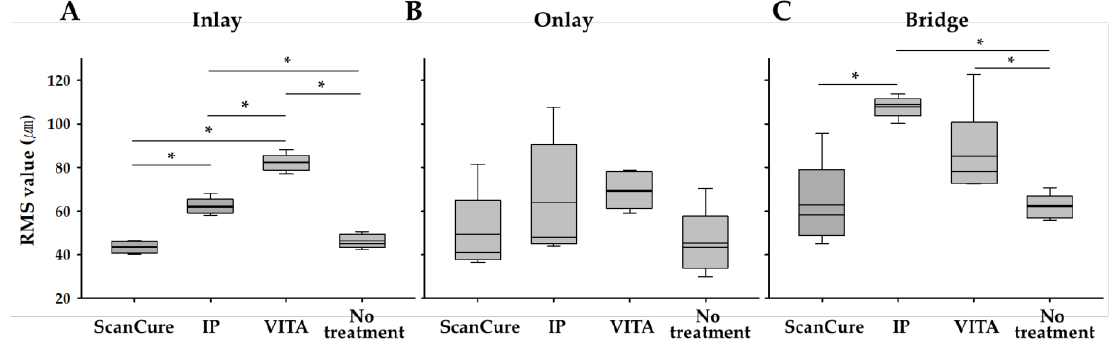
Figure 2. Box plots of the RMS values (trueness, n = 5) for four experimental groups (ScanCure, IP, VITA, no treatment, * p < 0.0083 by Bonferroni correction method) in three reference models. ( A ) inlay model, ( B ) onlay model, ( C ) bridge model.